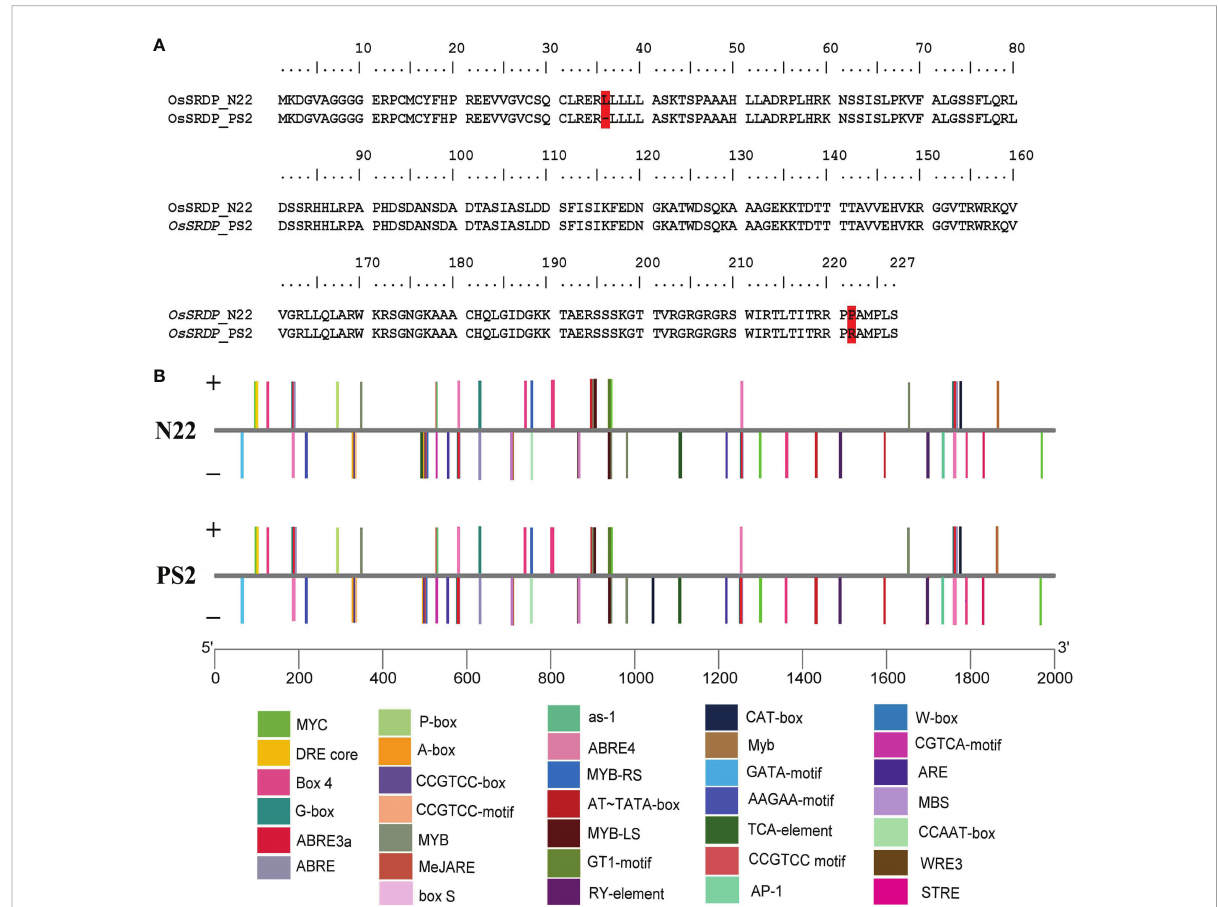
FIGURE 1 Assessment of the OsSRDP gene and its promoter sequences from N22 and PS2. (A) Variation of amino acid sequences of the OsSRDP gene from N22 and PS2. The red color highlight indicates the variation. (B) Schematic illustration of stress-related cis -acting regulatory elements in the promoter region of the OsSRDP gene from N22 and PS2. Different cis-acting elements in the 2-kb upstream region from the start codon of OsSRDP are illustrated by different colors in the bar chart and distributed on the sense strand and reverse strand indicated above and below the middle lines,